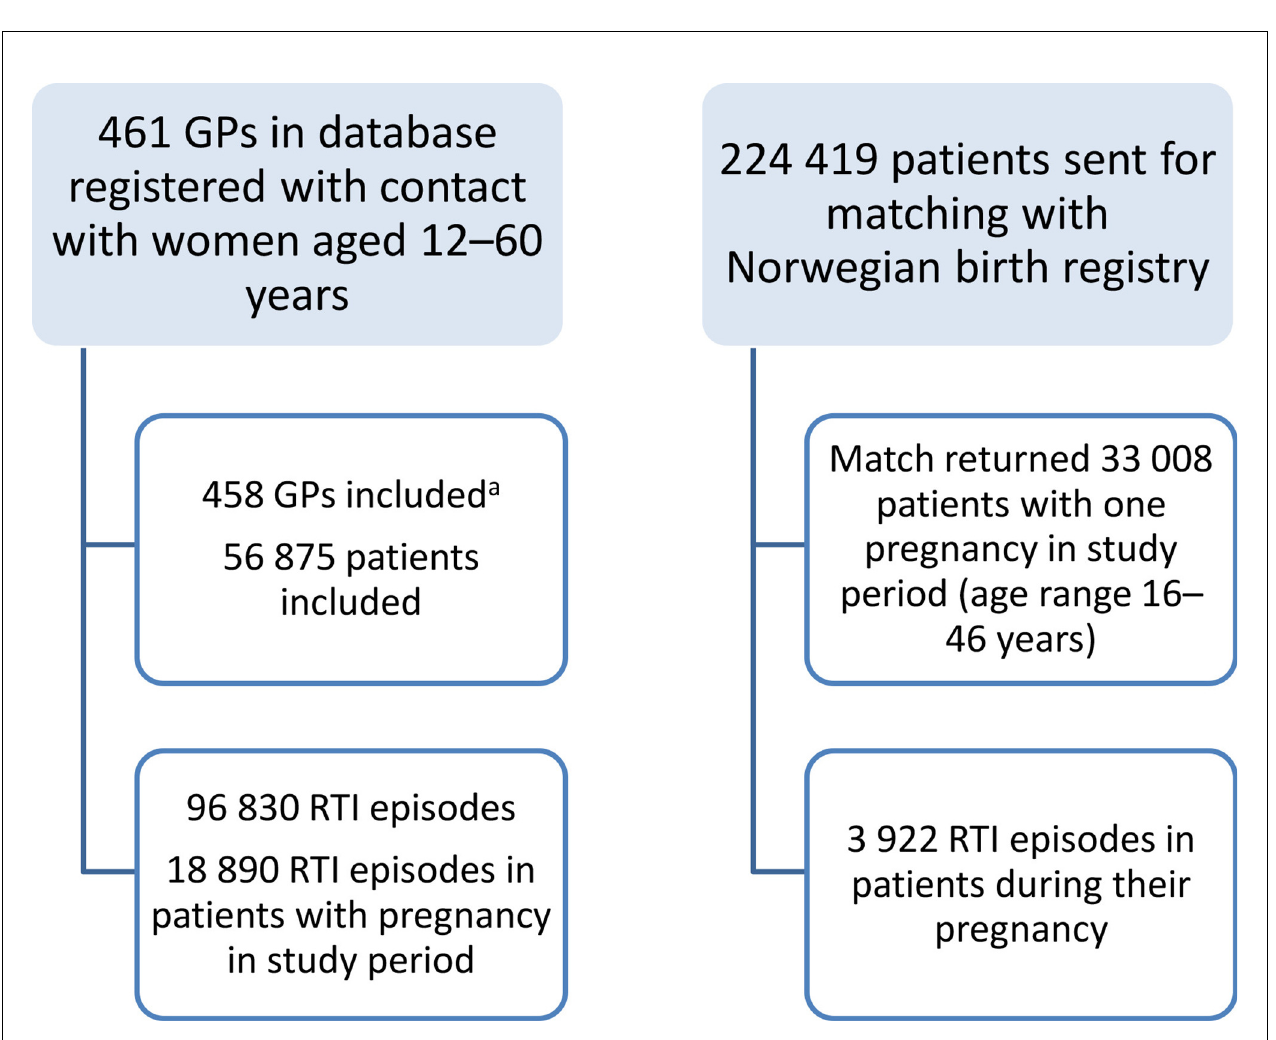
Figure 1. Selection of GPs and patients from the Rx-PAD study database and the Norwegian birth registry in the study period December 2004– February 2007. a GPs with <10 episodes were excluded. RTI = respiratory tract infection. Rx-PAD = Peer Academic